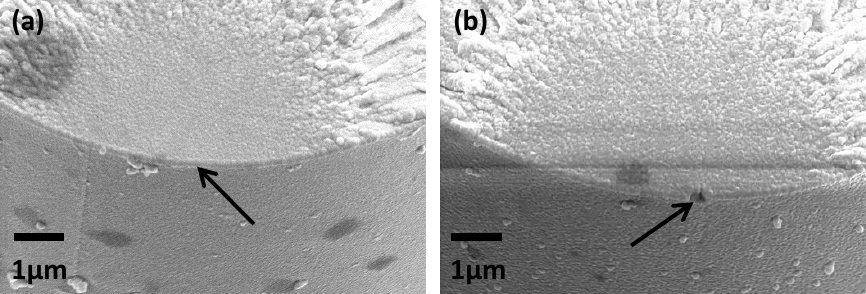
Figure 13. Fracture mirror region of 450 °C heat-treated fibres; ( a ) no visible flaw and ( b ) visible semi-circular flaw at the origin of fracture.